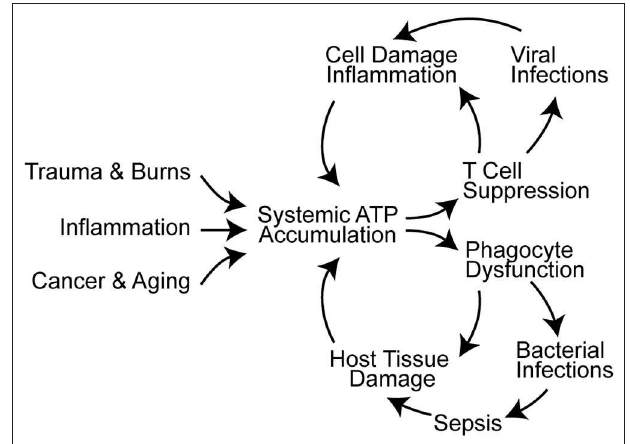
FIGURE 2 | Systemic ATP accumulation impairs the autocrine purinergic signaling mechanisms that regulate immune functions. Trauma, burns, inflammation, cancer, and aging are associated with systemic ATP accumulation that promotes immune cell dysfunction (16, 88–90). This results in infections, sepsis, and additional cell damage that exacerbates systemic ATP levels and propagates immune